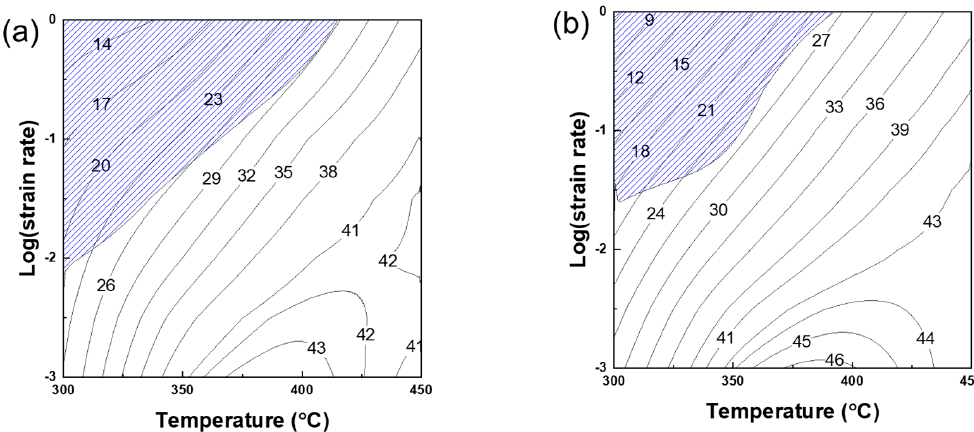
Figure 2. Processing map of ( a ) Al-6Mg and ( b ) Al-8Mg with 0.2 of a strain. The dashed area represents the instability region.